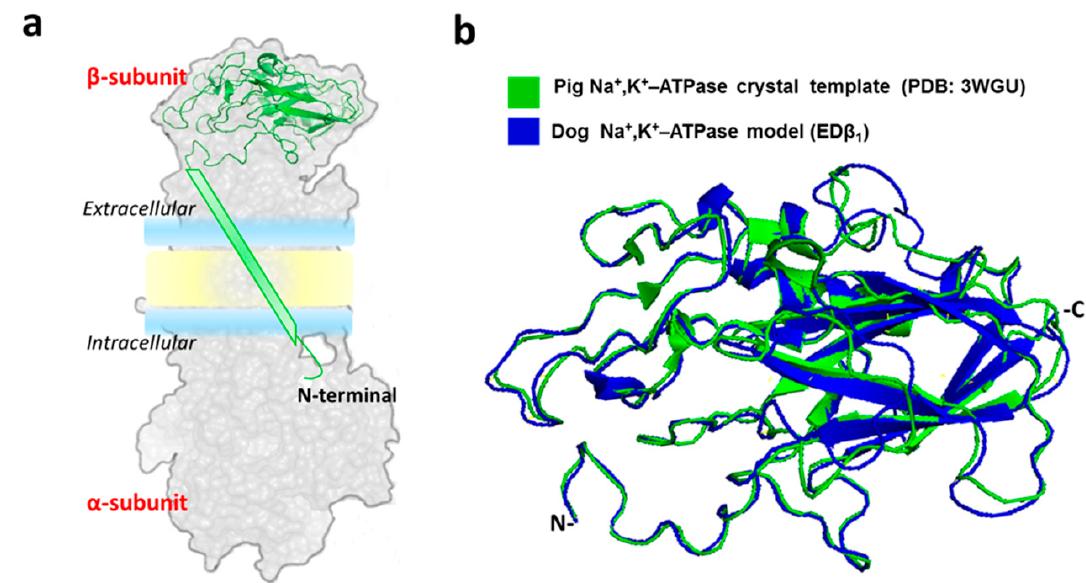
Figure 1. Generation of a high-quality model of canine β 1subunit extracellular domain. ( a ) The silhouette of the complete pig Na+, K+–ATPase structure (PDB ID = 3WGU). The β 1subunit structure is emphasized in green (cartoon model). ( b ) Structural alignment between the pig (green) and the canine (blue) β 1subunit extracellular domain, named ED β 1. Our model starts from threonine 60 where the single α -helix of TM domain of β 1the ends.